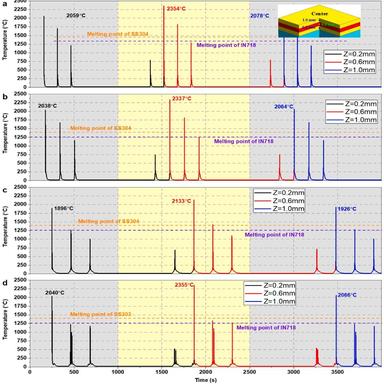
Predicted thermal evolutions at different deposition heights and the center of the MMS builds: (a) Case-1; (b) Case-2; (c) Case-3; (d) Case-4.